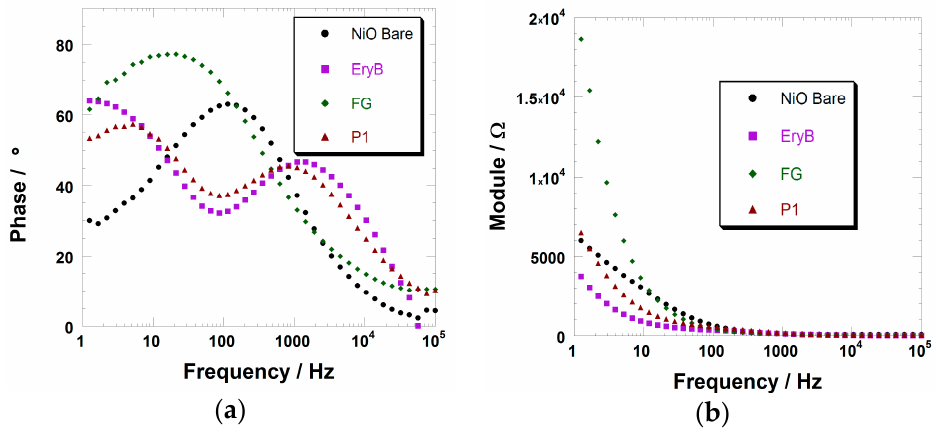
Figure 6. ( a ) Variation of the phase of the electrochemical impedance with the frequency of the potential stimulus for the cells with the bare, ERY-, P1-, and FG-sensitized NiO as the working electrode; ( b ) Variation of the impedance modulus with the frequency of stimulus for the four cells analyzed in the left frame.